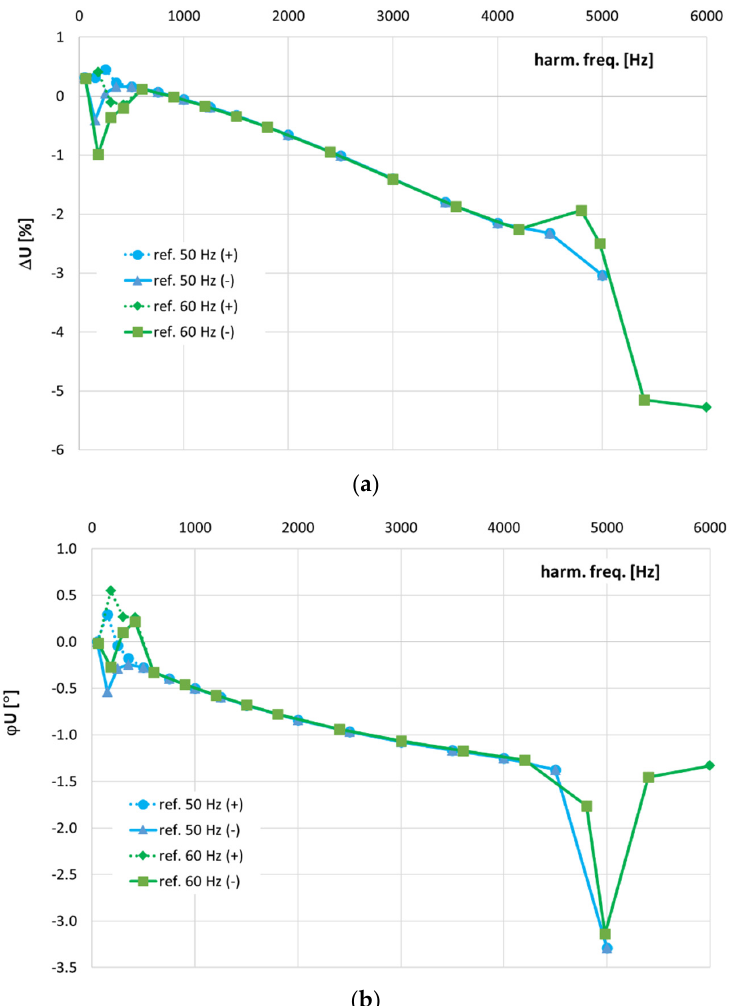
Figure 10. ( a ) The values of voltage ratio error of tested inductive VT. ( b ) The values of phase dis- placement of tested inductive